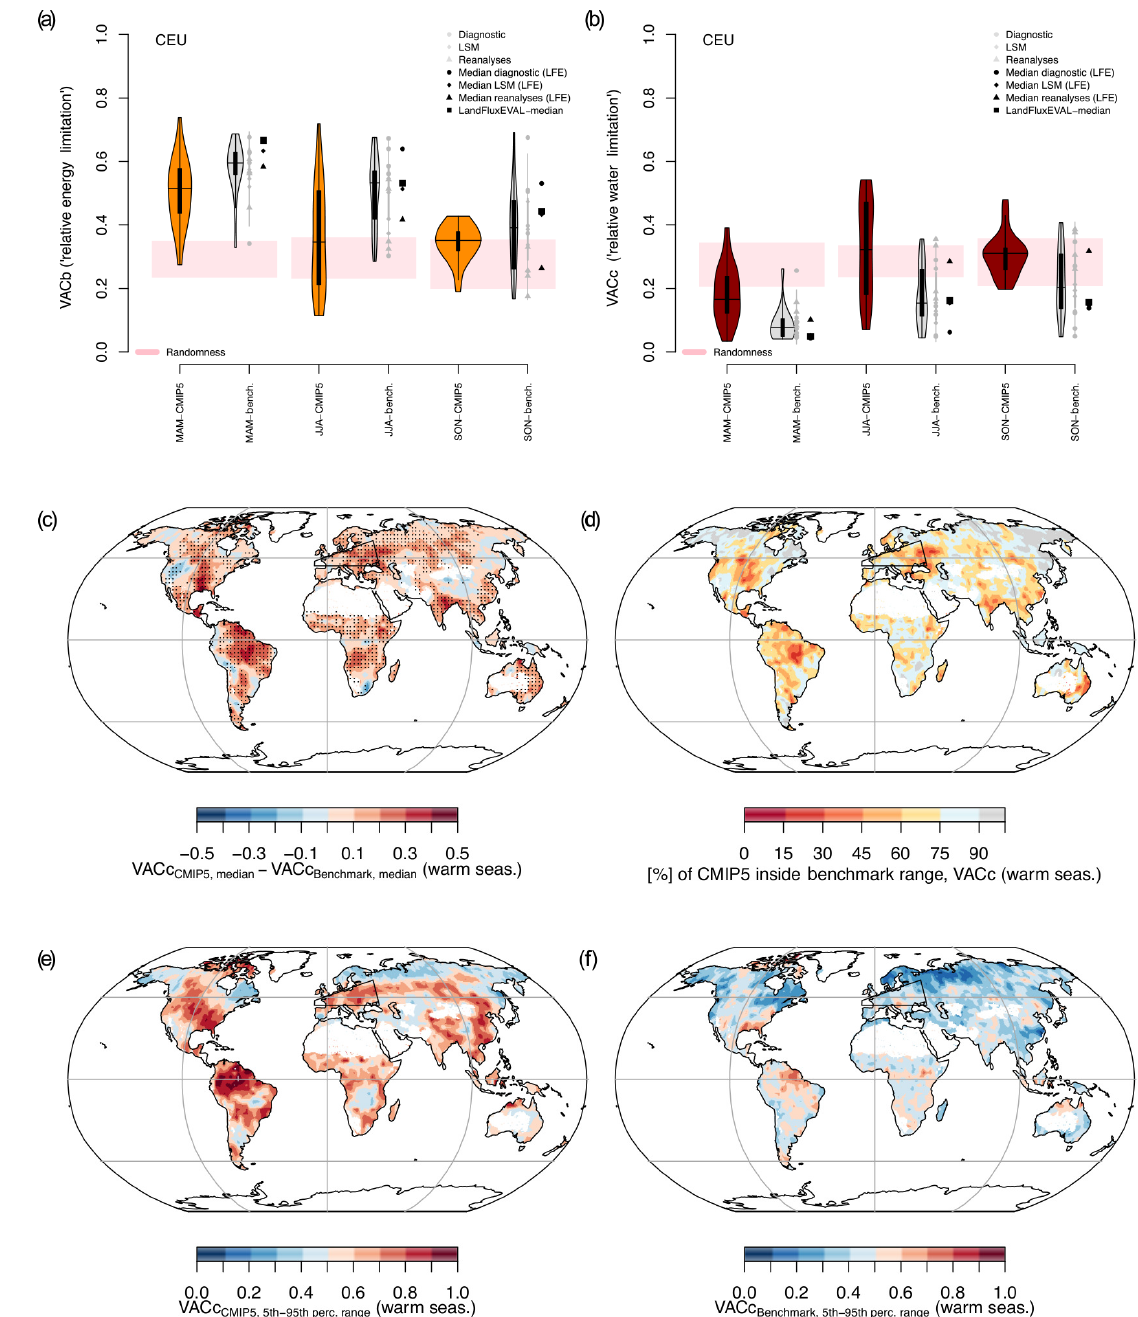
Figure 2. Evaluation of T –ET coupling in global climate models. (a, b) VACb and VACc coupling in the CMIP5 climate model ensemble and observations-based benchmarking datasets in central Europe (CEU, 1989–2005, area average) with systematic warm season differences (circles, diamonds, and triangles indicate diagnostic, land surface models, and reanalyses reference datasets, respectively). Randomness indicates the 5th to 95th percentile range obtained by randomly permutating both time series with respect to the other ( N = 100 times) to obtain independent data. (c) Difference in the VACc median of the CMIP5 ensemble and benchmarking datasets. (d) Fraction of CMIP5 models that are inside the 5th-95th percentile spread of the benchmarking datasets. (e, f) Range of VACc occurrences (5th to 95th percentile range) in CMIP5 models (e) and in the ensemble of observations (f)